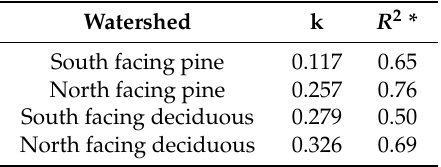
Table 4. Exponential decomposition k values for years